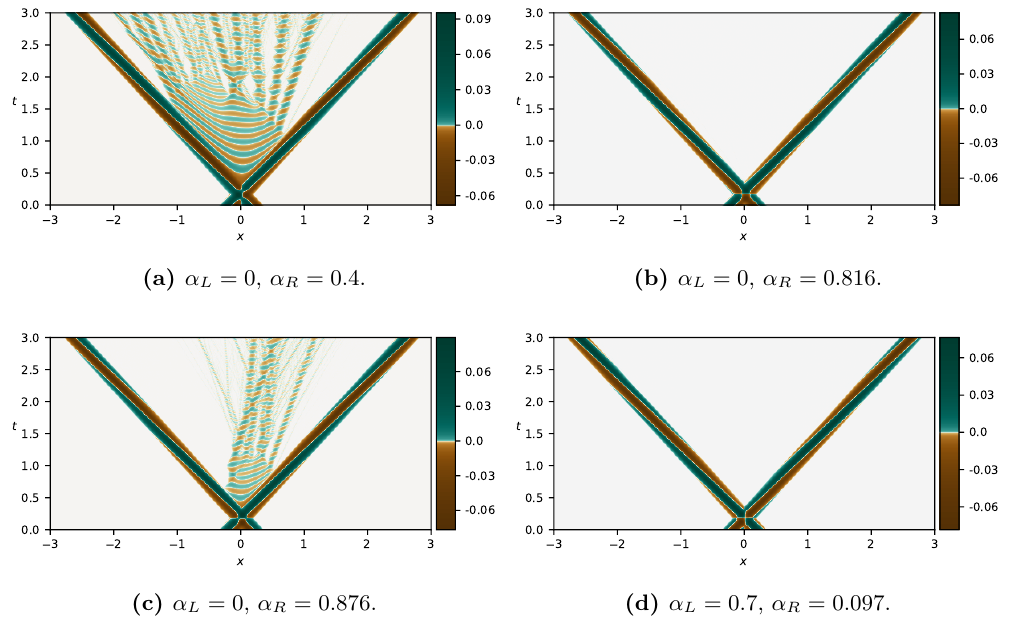
Figure 31 . The scattering process for initial con(cid:12)guration containing oscillons with speed V = 0 : 93, velocity of the border v = 0 and di(cid:11)erent phases (cid:11) L and (cid:11) R . by (3.12) taken at time t = 0. In (cid:12)gures 31a{31d we plot four cases of the time